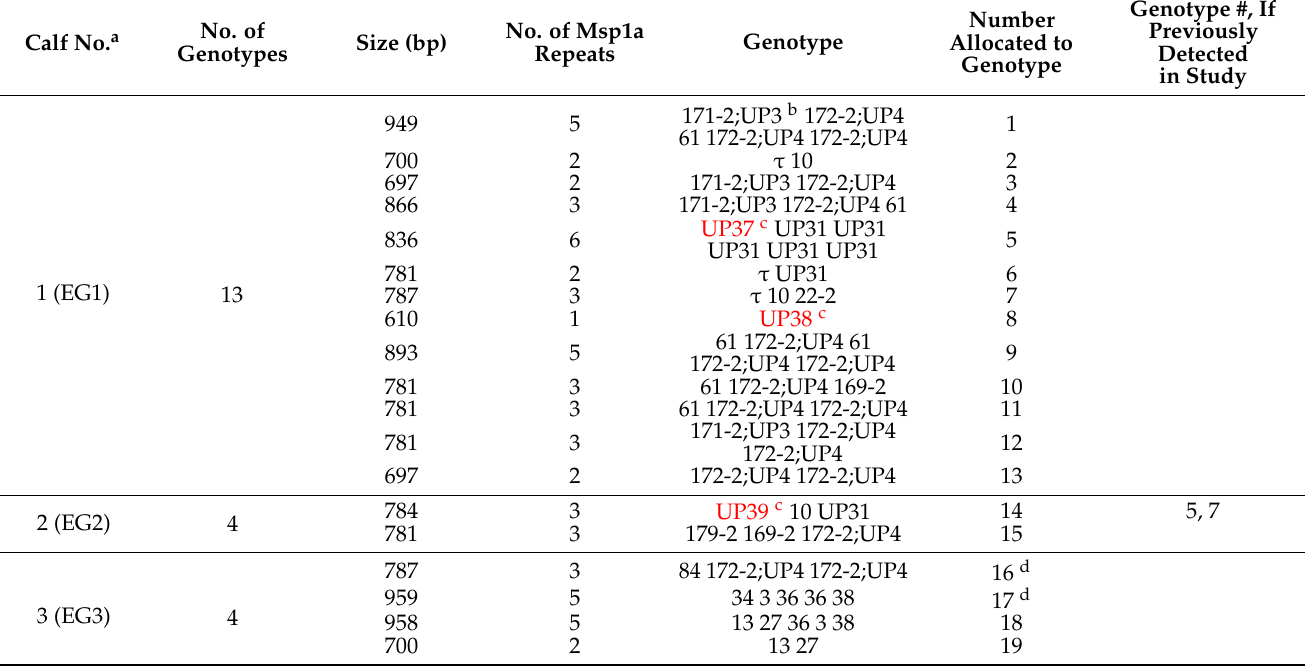
Table 1. Anaplasma marginale msp1 α genotypes identified from infected calves over the 12-month study